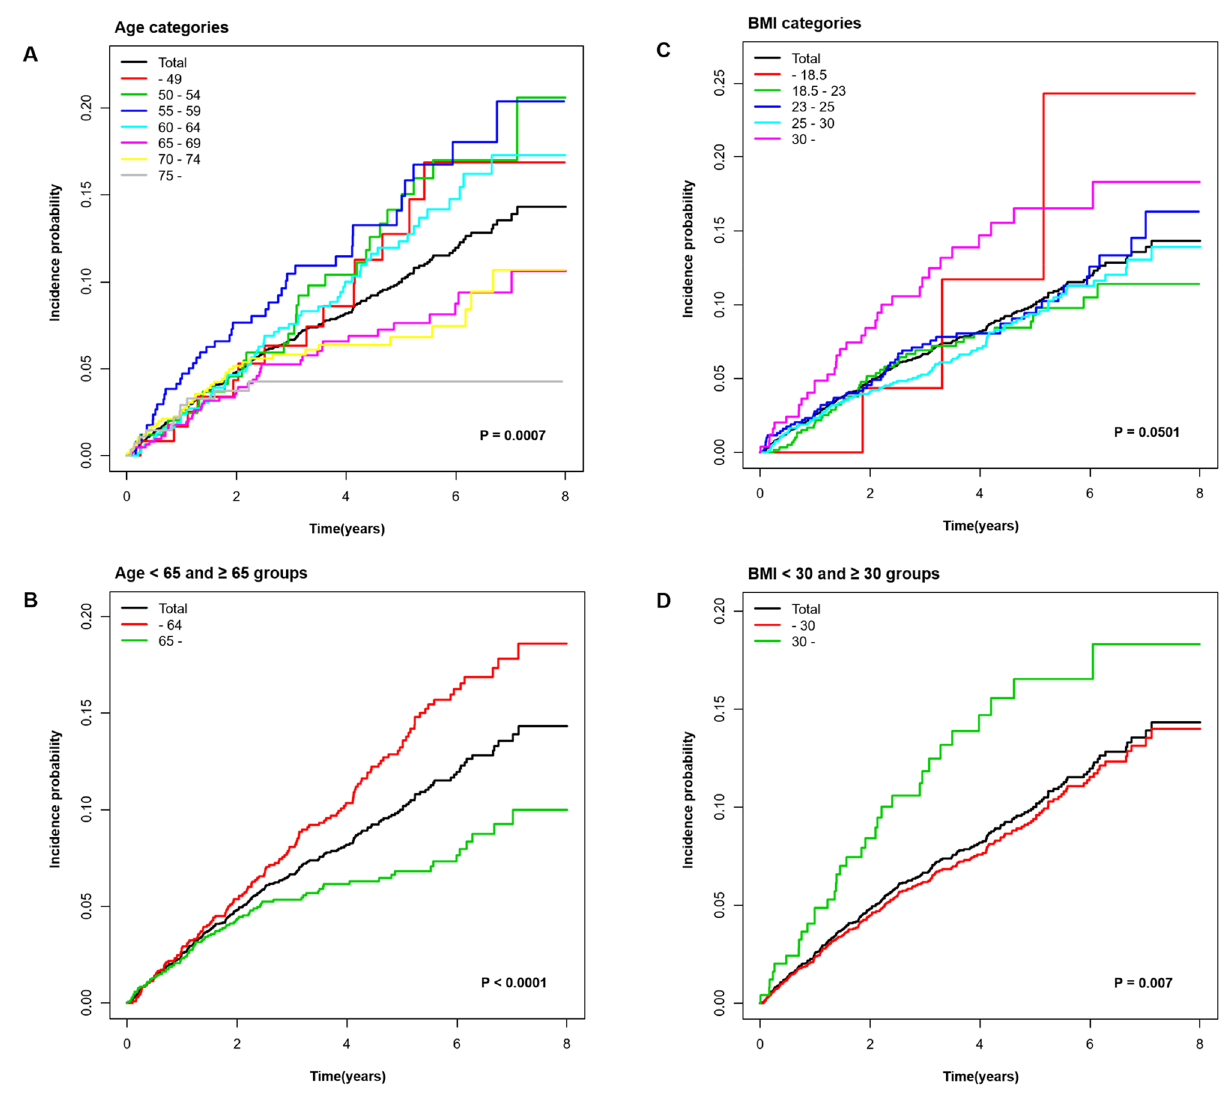
Figure 2. Cumulative incidence of TAA failure during follow-up according to age categories ( A ), age < 65 and ≥ 65 groups ( B ), BMI categories ( C ), and BMI < 30 and ≥ 30 groups. The log-rank test was applied to evaluate differences among the groups and calculate the P